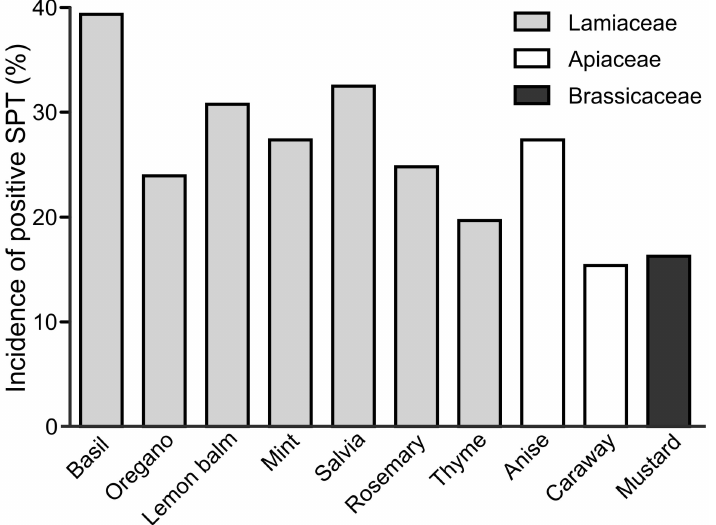
Figure 2. Incidence of positive SPT reaction to fresh extracts of basil, oregano, lemon balm, mint, salvia, rosemary, thyme anise, caraway and mustard in a group of adults ( n =